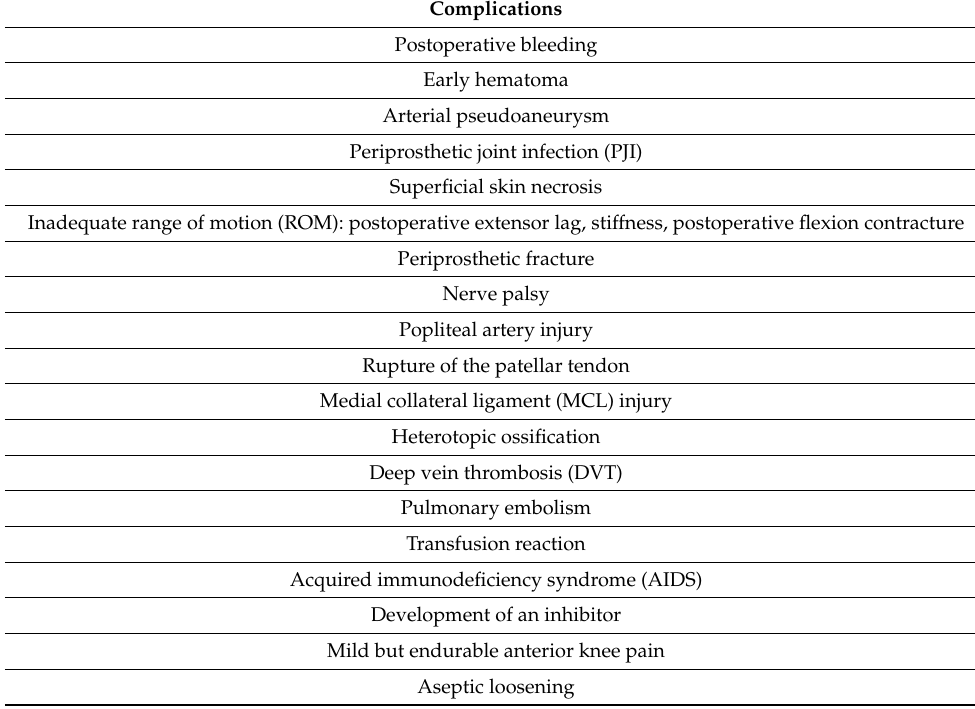
Table 2. Complications of total knee arthroplasty (TKA) in people with hemophilia